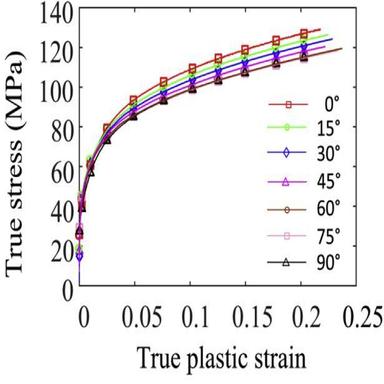
True stress-strain curves from uniaxial tension tests along every 15° from the RD. All curves are plotted up to necking.